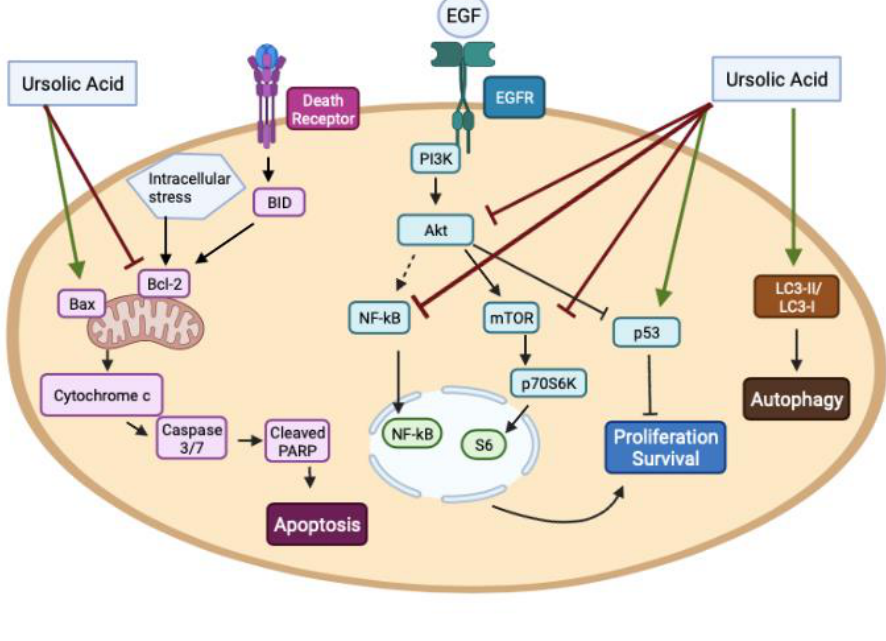
Figure 2. Ursolic acid reduced proliferation and induced apoptosis and autophagy of lung cancer cells in vitro. UA inhibited the phosphorylation/activation of Akt [73,81], mTOR [70,76] and NF-kB [65,73] and increased p53 protein levels [65], leading to inhibition of proliferation and survival. Furthermore, UA increased the proapoptotic protein Bax and decreased the antiapoptotic protein Bcl-2 [65,70,75]. An increase in cleaved caspases 3 and 7 was observed, leading to an increase in cleaved PARP and apoptosis [66,73,80]. An increase in LC3-II protein levels, a marker of